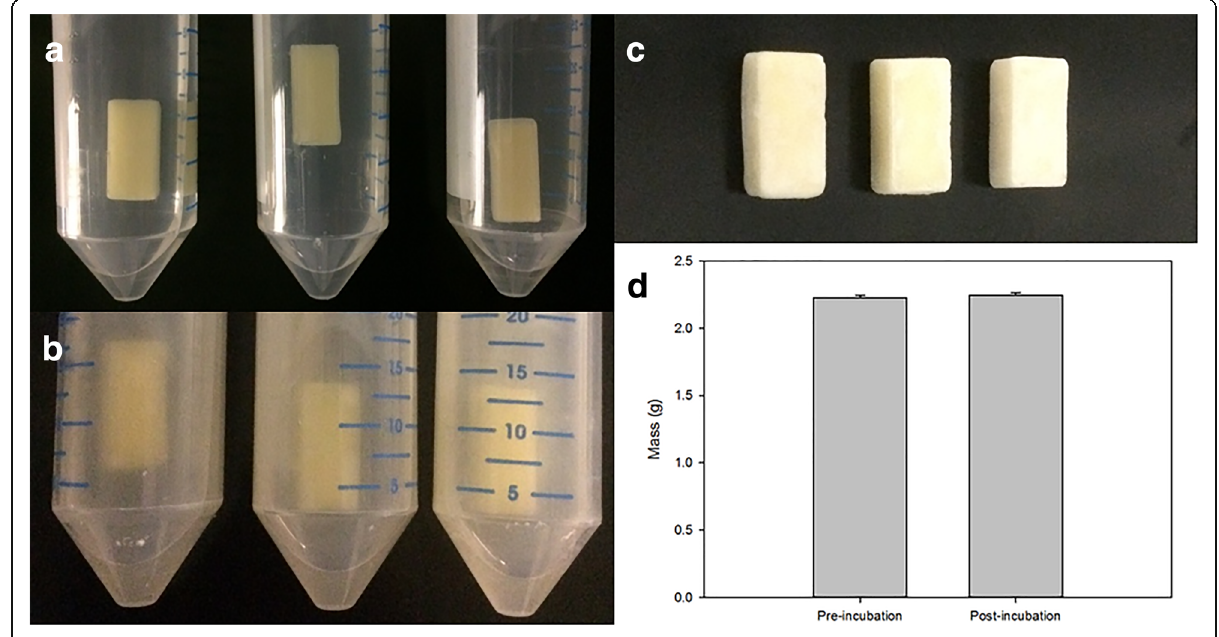
Fig. 4 Resistance of wax-coated capsules to simulated GI fluids ( n = 3). To demonstrate the high resistance of the wax coating to enzymatic activity and low pH, the wax-coated capsules were exposed to simulated GI fluids at 37 °C. Visual control after 2 h incubation in simulated pepsin-containing gastric fluid USP at pH 1.2 ( a ) and subsequent 24 h in pancreatin-containing simulated intestinal fluid USP at pH 6.8 ( b ) revealed no apparent morphological changes ( c ). Moreover, no significant change in mass was observed ( p = 0.400, mean ± standard deviation, d ). GI: Gastrointestinal; USP: United States